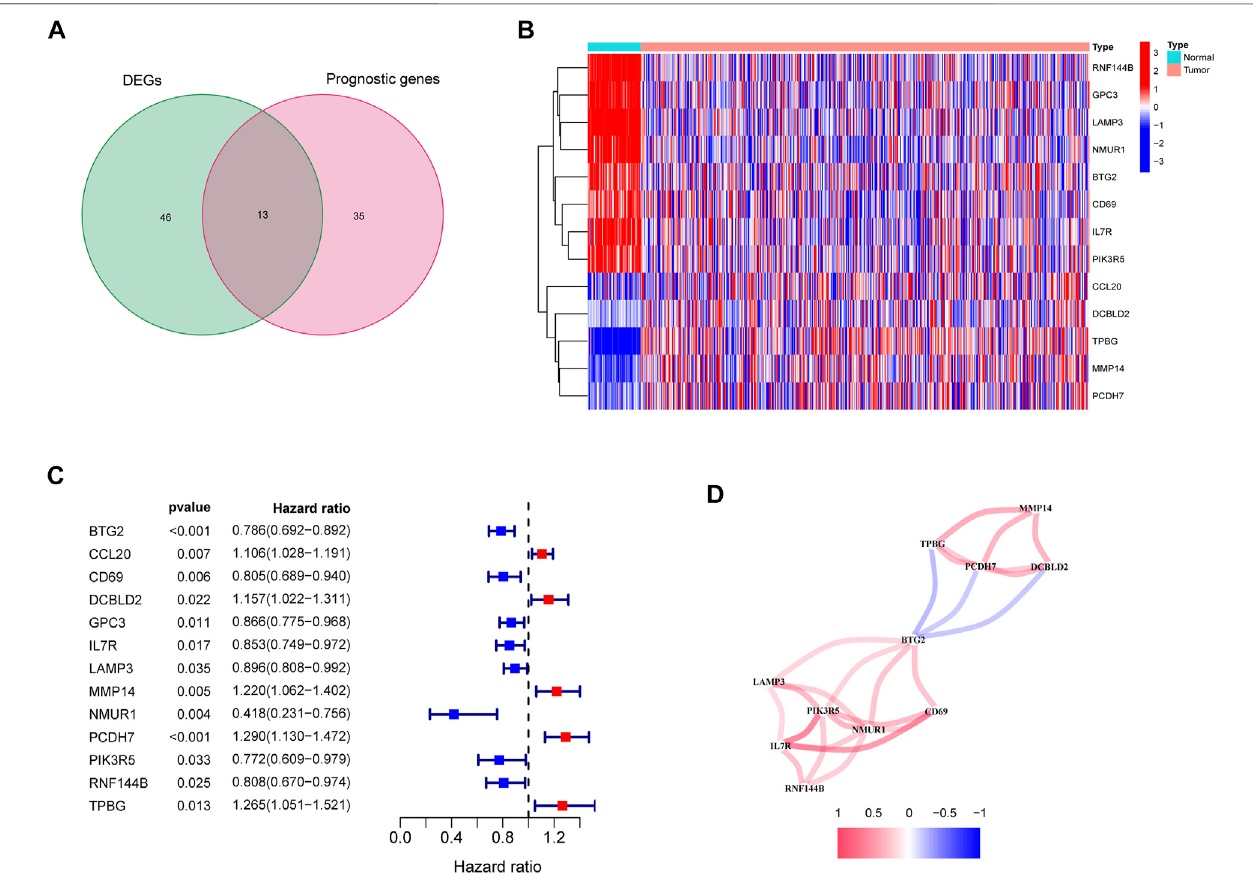
FIGURE2| Identi fi cationofthecandidatein fl ammatoryresponse-relatedgenesintheTCGAcohort. (A) VenndiagramtoidentifyDEGsbetweenLUADtissuesand adjacent normal tissues. (B) The 13 overlapping genes expression between LUAD tissues and adjacent normal tissues. (C) Forest plots showing the results of the association between 13 overlapping gene expression and OS. (D) The correlation network of candidate genes.